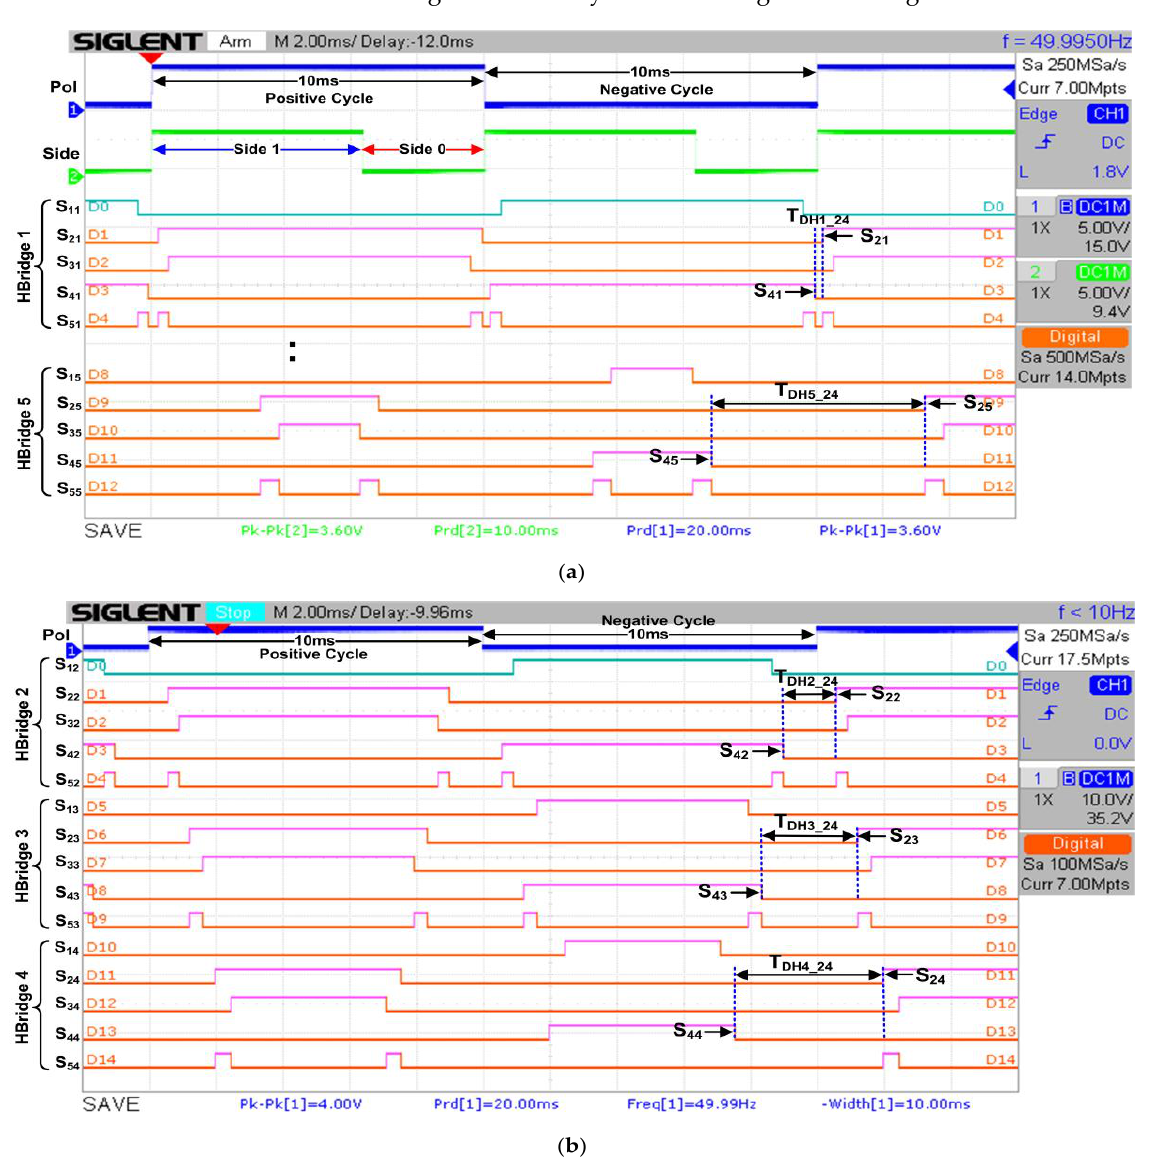
Figure 21. Hardware measurement of the SHE digital switching controller’s output gating pulses: ( a ) Output gating pulses for H-Bridge 1 (“S 11 ” to “S 51 ”) and H-Bridge 5 (“S 15 ” to “S 55 ”). ( b ) Output gating pulses for H-Bridge 2 (“S 12 ” to “S 52 ”), H-Bridge 3 (“S 13 ” to “S 53 ”), and H-Bridge 4 (“S 14 ” to “S 54